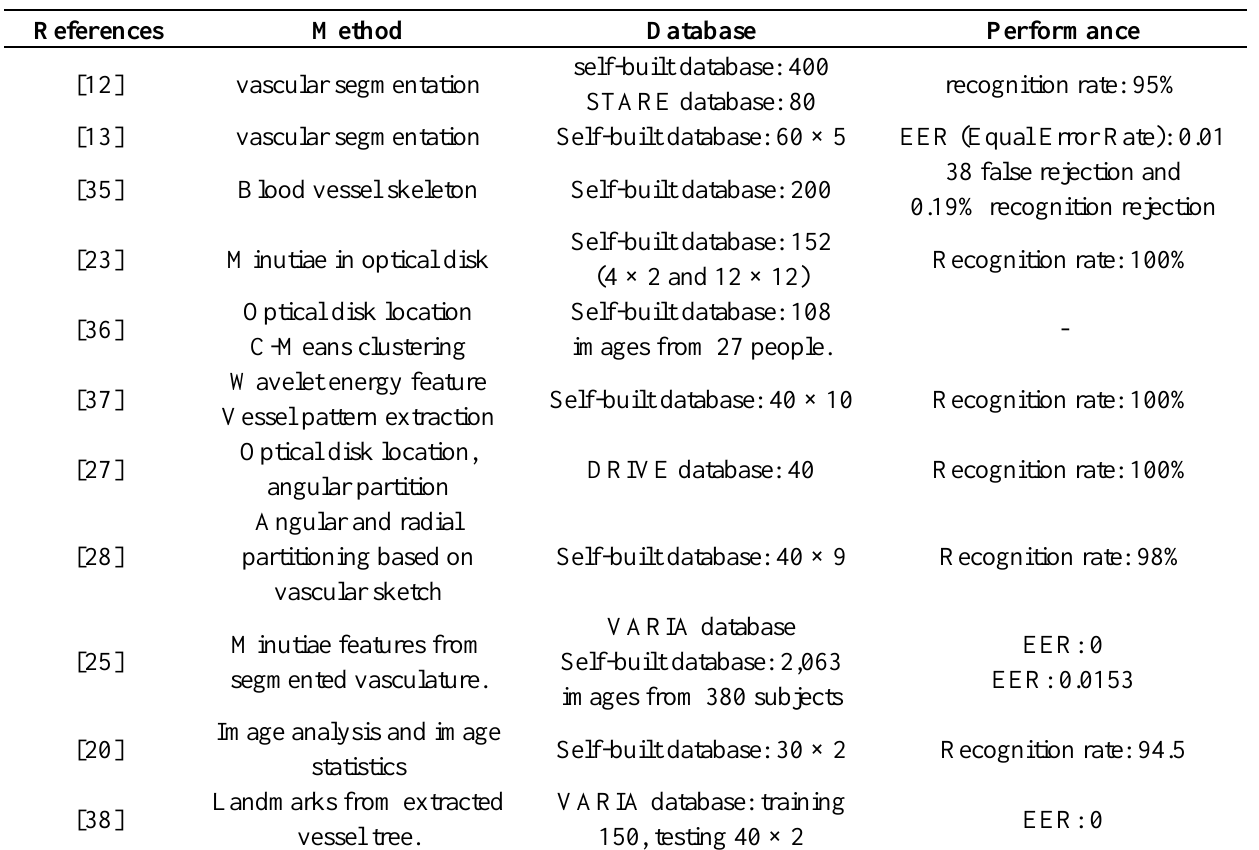
Table 1. Methods for retinal